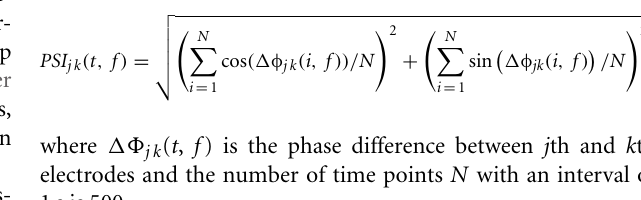
EEG and EOG signals were amplified using the Neuroscan system (Neuroscan, USA). The sampling rate was 500